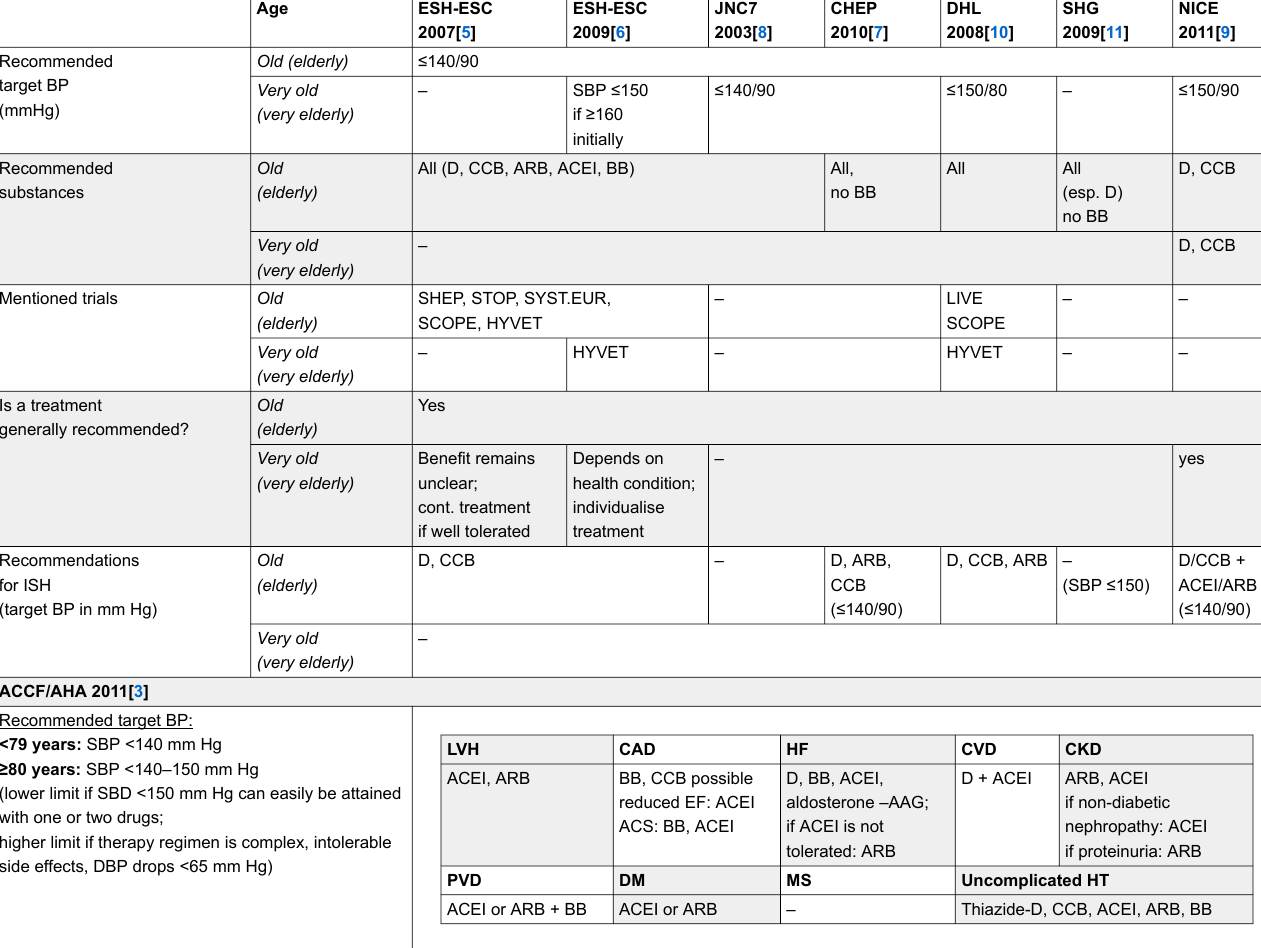
Table 3: Hypertension treatment recommendations for the elderly and very elderly according to investigated